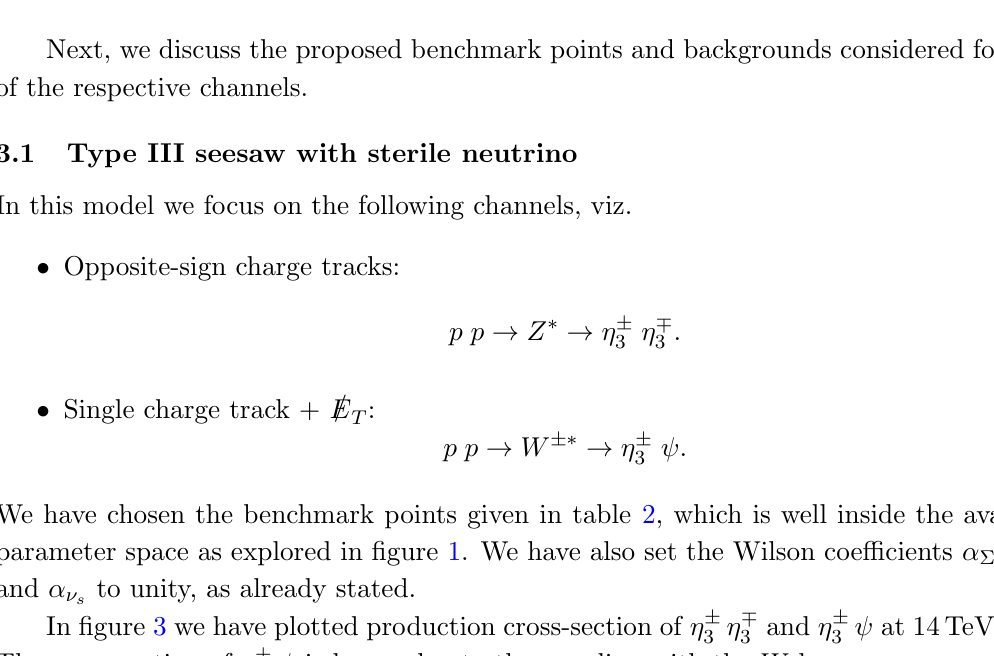
Table 2 . Benchmark points for studying the discovery prospects of stable charged tracks of (cid:17) (cid:6) and for Type III seesaw model at 14 TeV run of